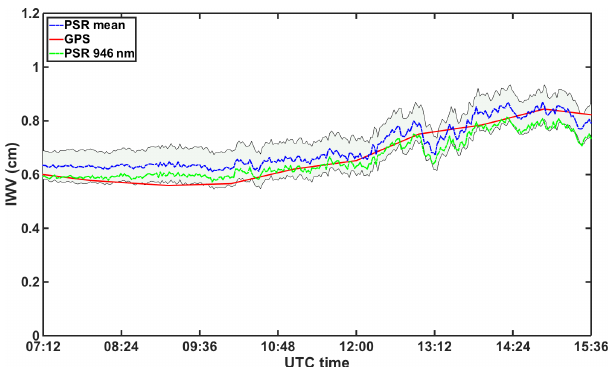
Figure 5. Spectra of direct solar irradiance at SZA = 0 ◦ with AOD = 0 and IWV = 0cm (black) and 2cm (red), as calculated from MODTRAN 5.2.1